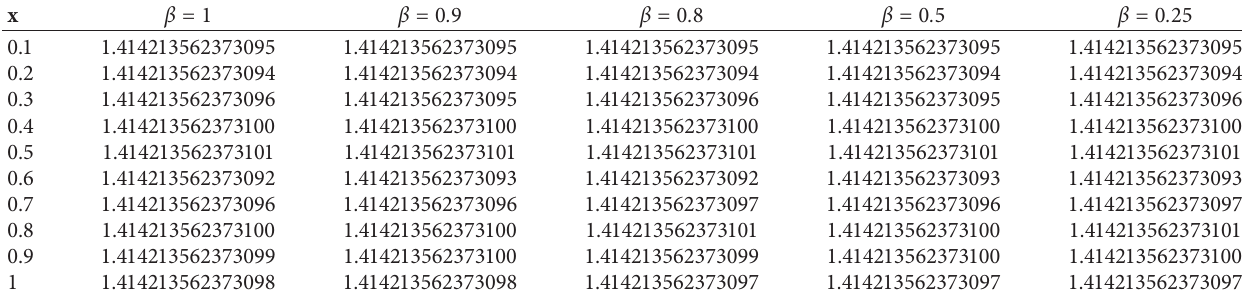
Table 1: The results are obtained for different fractional orders and N � 250.